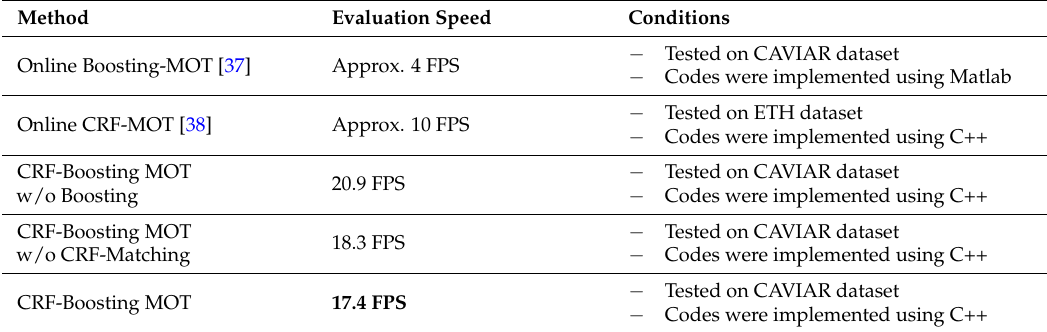
Table 7. Comparison of the Execution